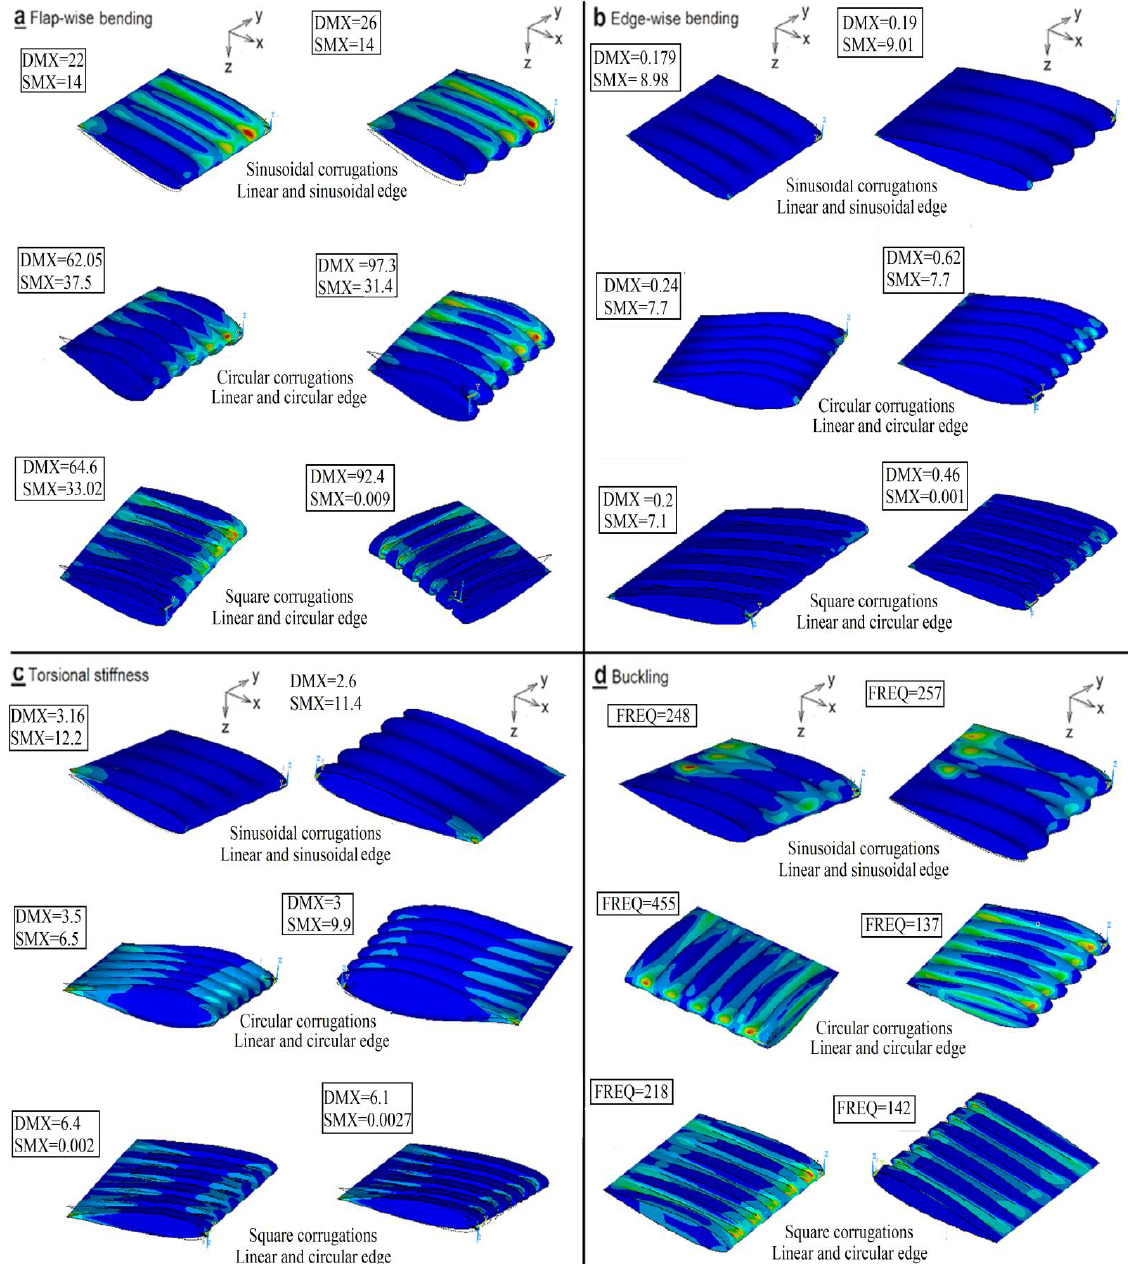
Figure 6. FEM simulation of the introduced flexure hinge designs at unit load conditions. ( a ) Flap-wise deformation, ( b ) the edge-wise deformation, ( c ) the twist deformation, ( d ) buckling results.